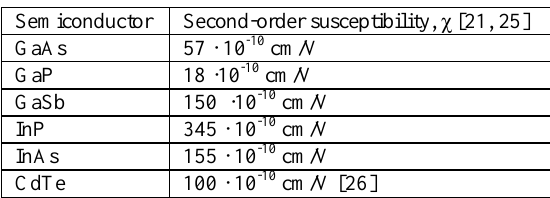
Table. Second-order susceptibility of several